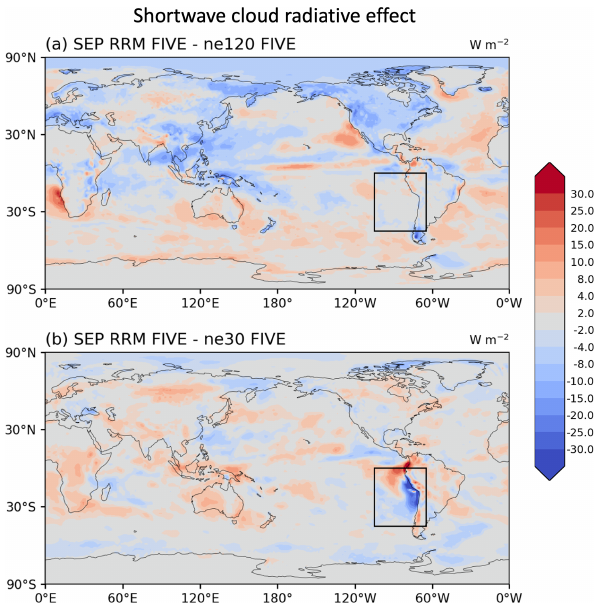
Figure 8. Same as Fig. 5 but for shortwave cloud radiative effect.